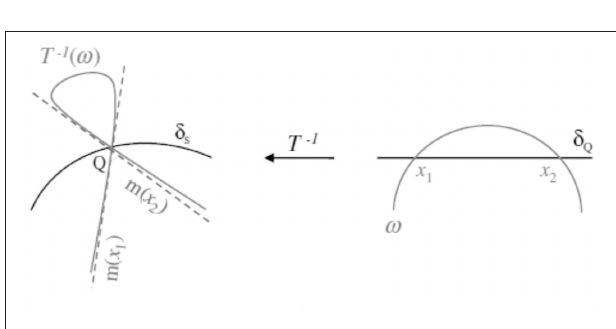
FIGURE 3 | Creation of a